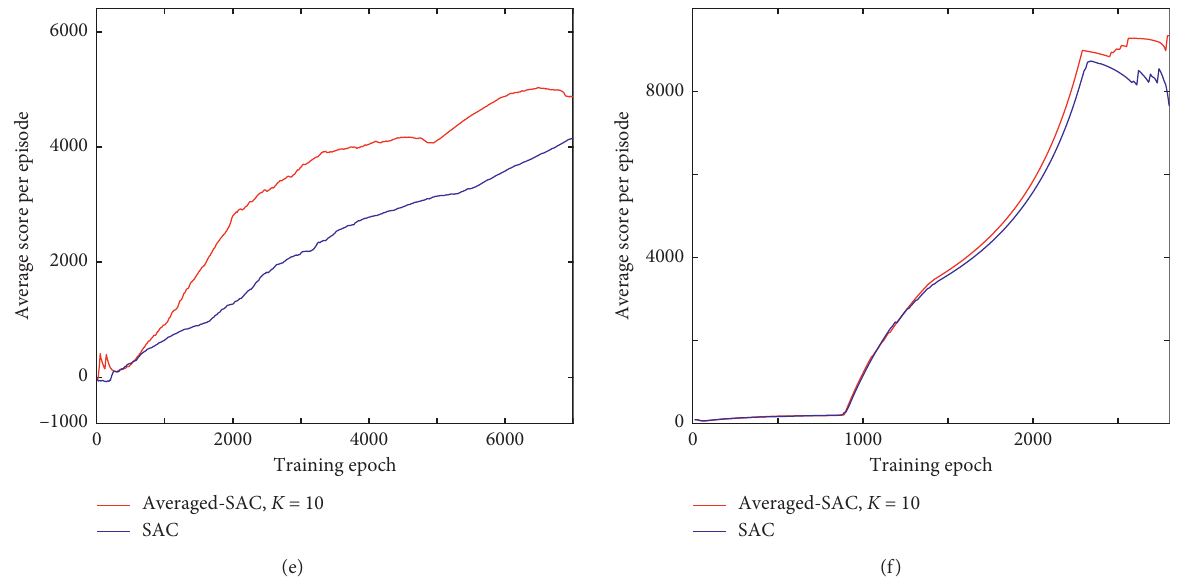
Figure 2: Results of Averaged-SAC and SAC in 6 MuJoCo games. (a) Ant-v2. (b) HalfCheetah-v2. (c) Hopper-v2. (d) Humanoid-v2. (e) Walker2D-v2. (f)